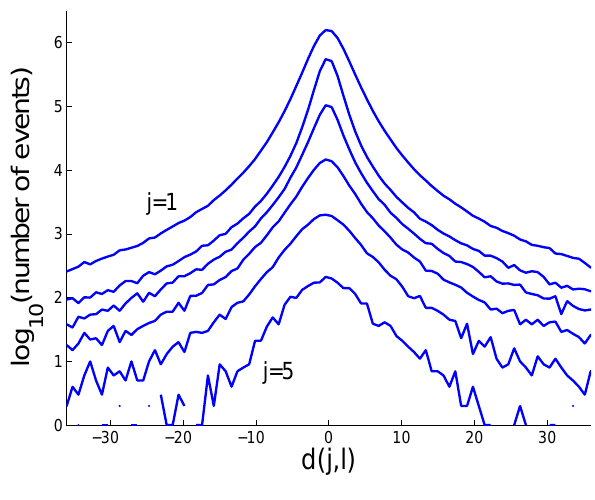
Fig. 3. Histograms of 2-D discrete wavelet coefficients computed from 54 Quiet Sun images taken by EIT at 19.5nm during the year